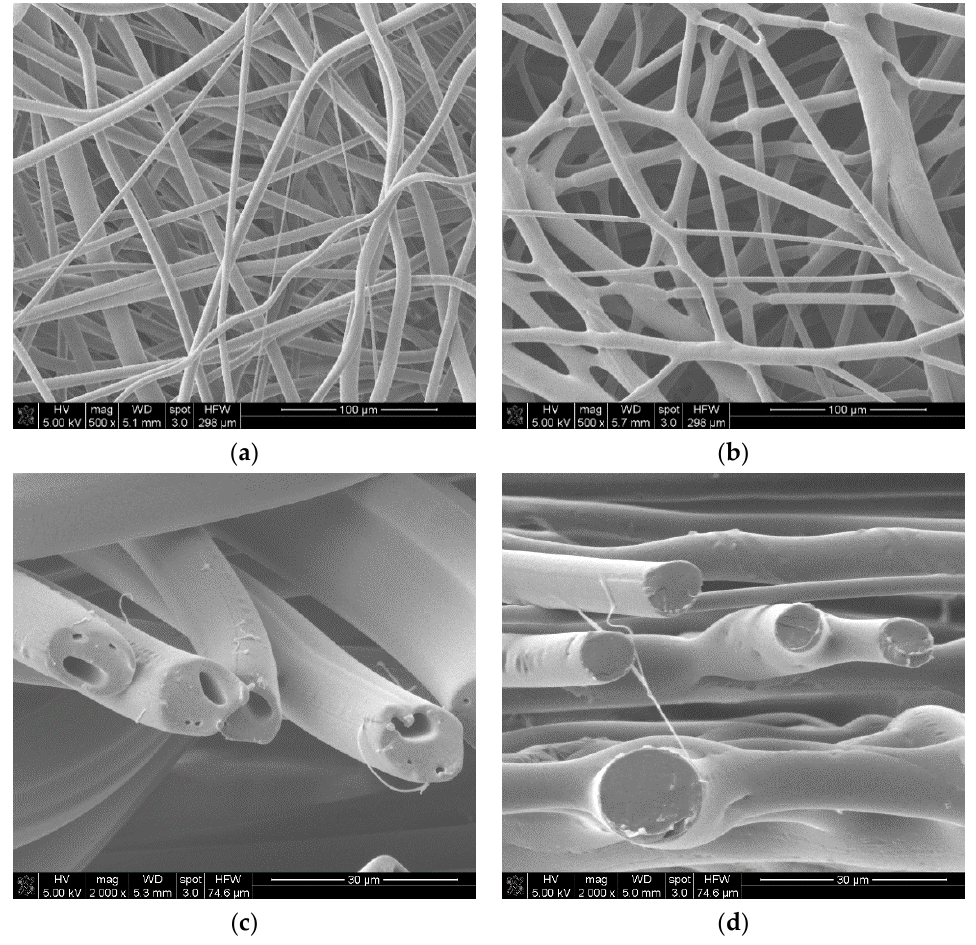
Figure 3. SEM images of ( a )—nonwoven fabric surface morphology; ( b )—nonwoven fabric after the thermal stabilization surface morphology; ( c )—cross-section of the nonwoven fabric; ( d )—cross-section of the nonwoven fabric after the thermal stabilization process.